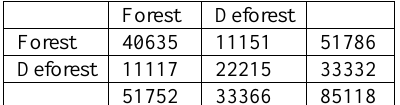
Table 2: confusion matrix of simulated deforestation map (t=52, Neighbourhood window: